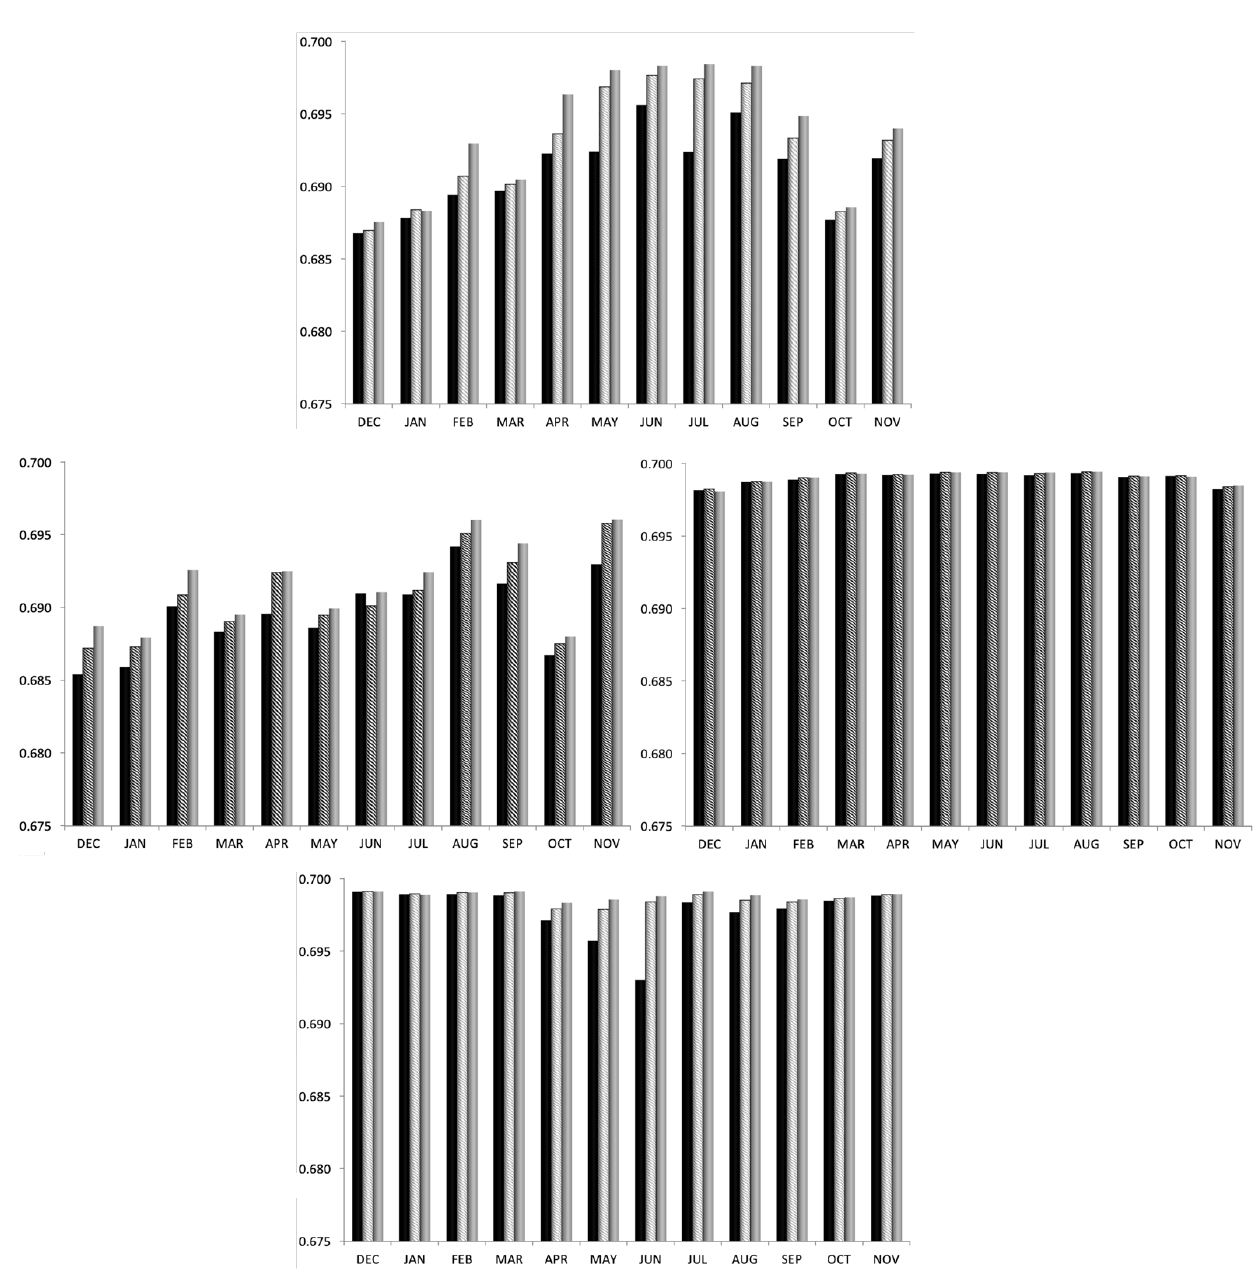
Figure 7. CS values calculated depending on the season (from December 2018 to November 2019); orientation of north ( top ), east ( right ), south ( bottom ), and west ( left ); and elevation from the horizontal level of 15° (black), 30° (striped), and 45° (grey).